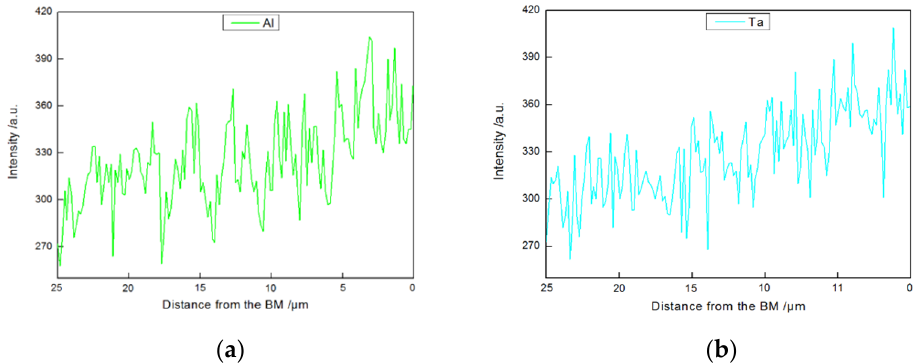
Figure 5. The EDS line scans of Al and Ta elements in the ISZ of the brazing joints, where the scan direction corresponds to the arrow in Figure 4a: ( a ) Al element ( b ) Ta element.